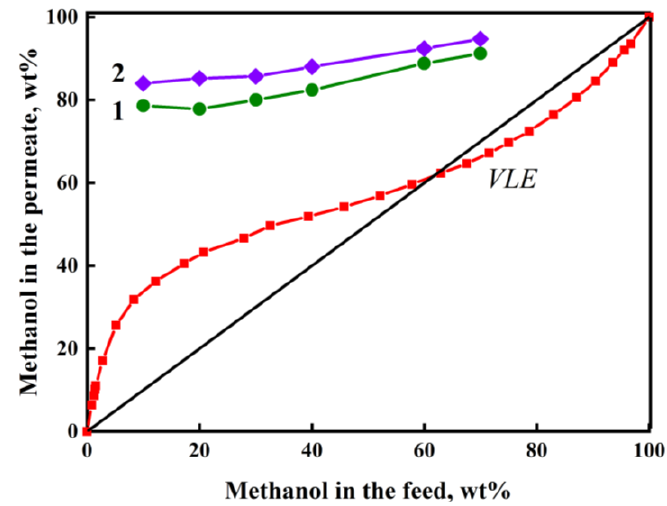
Figure 8. Dependence of methanol concentration in the permeate on methanol concentration in the feed for pervaporation of the MeOH/DMC mixture using the (1) PHI and (2) PHI-Cu(I) membranes, 40 °C. Red line is the curve of vapor-liquid equilibrium (VLE) in the MeOH/DMC system, 40 °C.